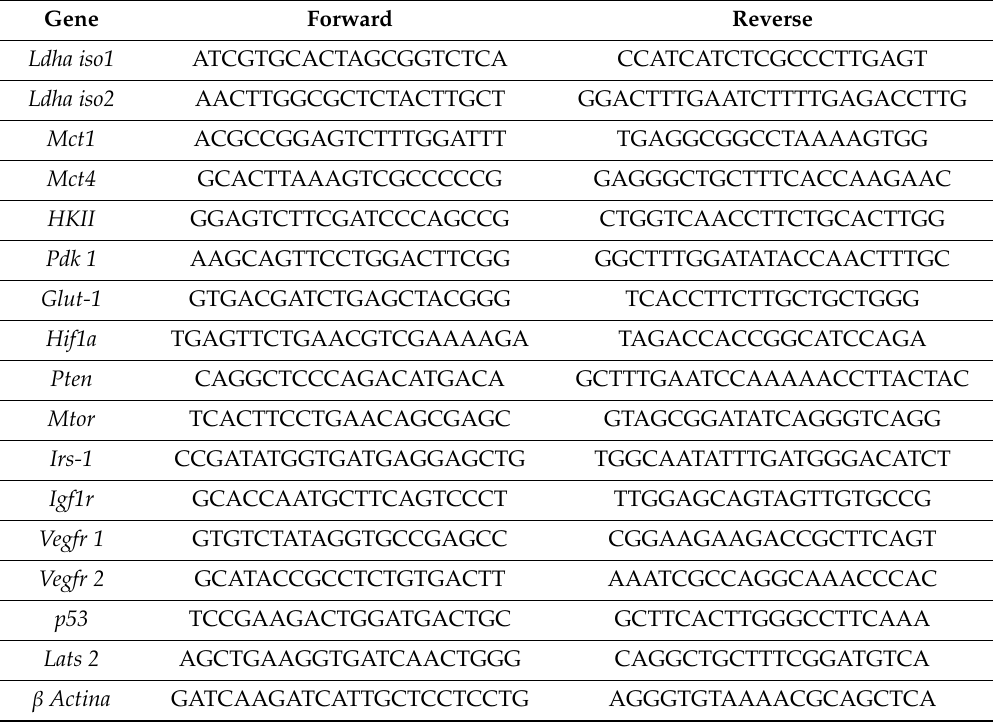
Table 1. Primers analyzed by